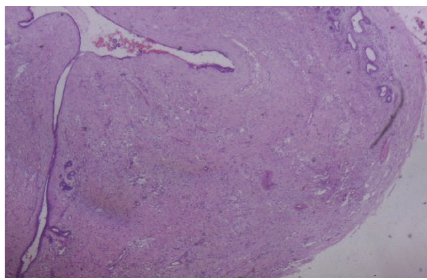
Figure 2: (H&E × 100) Encapsulated growth (fibroadenoma) con- sisting of compressed glands and ducts within a dense fibrocollage- nous stroma.